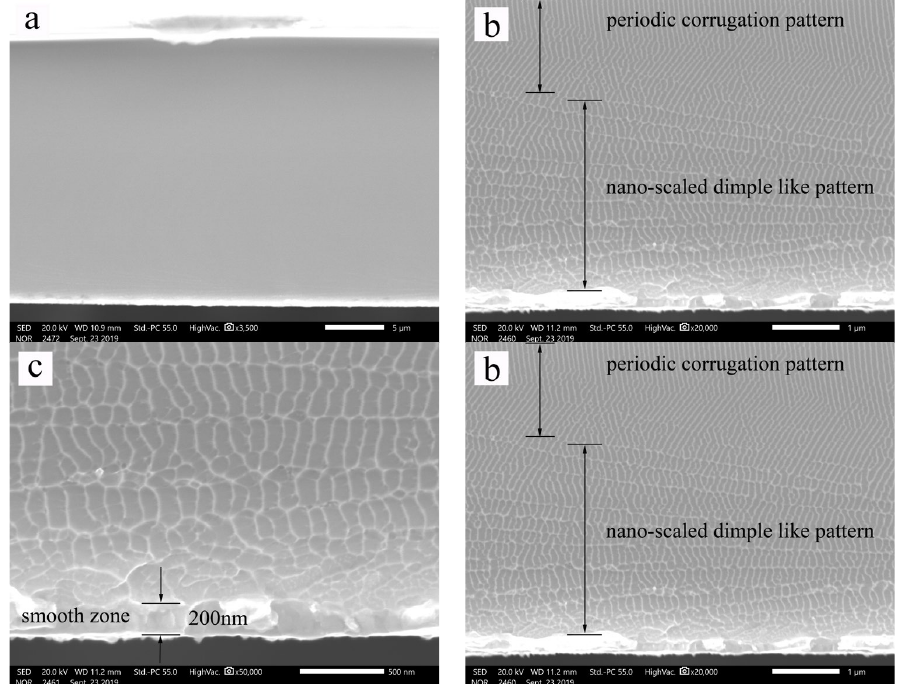
Figure 7. Fracture surfaces for S380: overview of fracture surface ( a ); enlarged images for nano- scaled dimple- like pattern ( b ); smooth zone ( c ); mist zone ( d ).